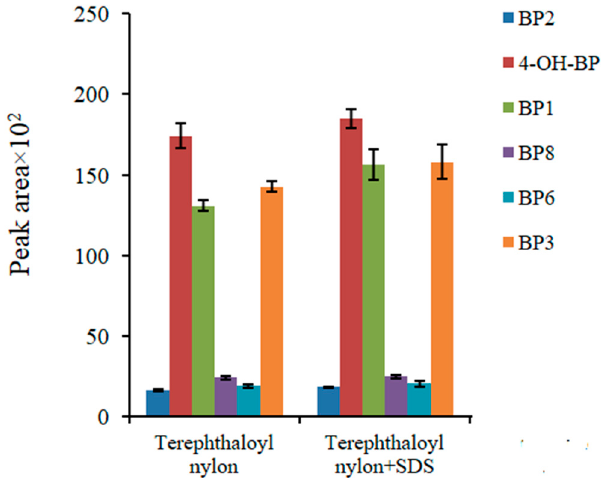
Figure 3. The effect of the addition of sodium dodecyl sulfate (SDS) on the extraction capabilities of the terephthaloyl-based magnetic nanocomposite. The analytes are: 2,2 ′ ,4,4 ′ -tetrahydroxybenzophenone (BP-2), 4-hydroxybenzophenone (4-OH-BP), 2,4- dihydroxybenzophenone (BP-1), 2,2 ′ -dihydroxy-4-methoxybenzophenone (BP-8), 2,2 ′ -dihydroxy- 4,4 ′ -dimethoxybenzophenone (BP-6), and 2-hydroxy-4-methoxybenzophenone (BP-3).